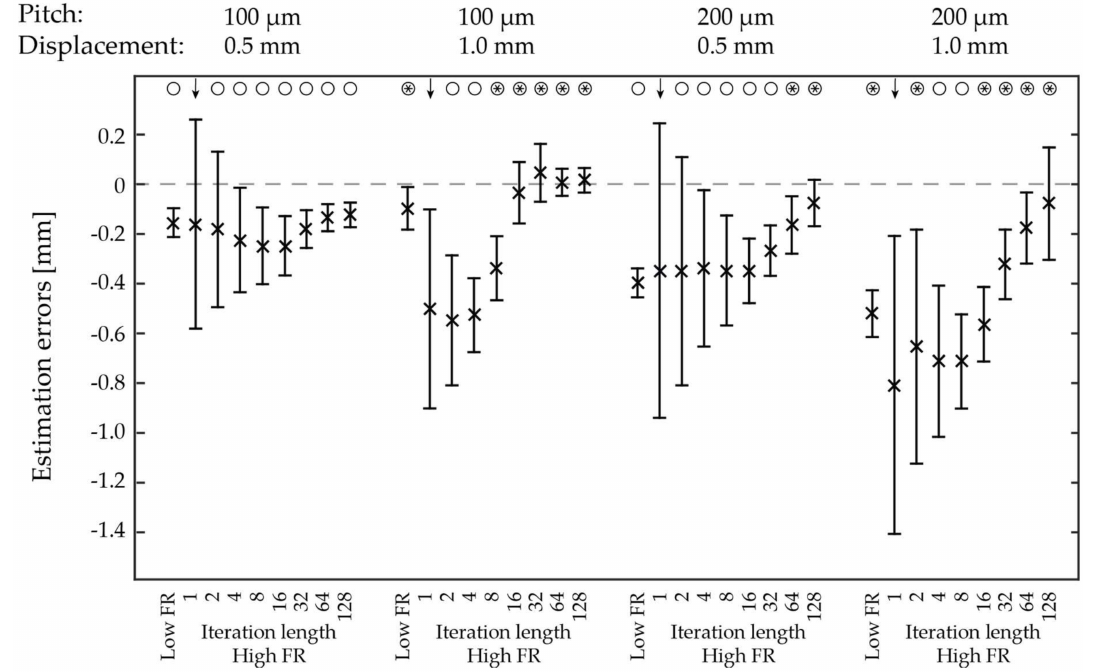
Figure 6. Lateral estimation errors of the displacement for two different displacements each using two different pitches (100 µ m and 200 µ m). The crosses indicate the mean estimation error for each setting with the error bars indicating ± one standard deviation. Significant changes ( p < 0.05) were calculated compared to k = 1 in each setting (marked with an arrow). The star indicates a change in the mean estimation error and a circle indicates a change in the standard deviation. FR signifies frame rate: low = 41 Hz, high = 1302 Hz.